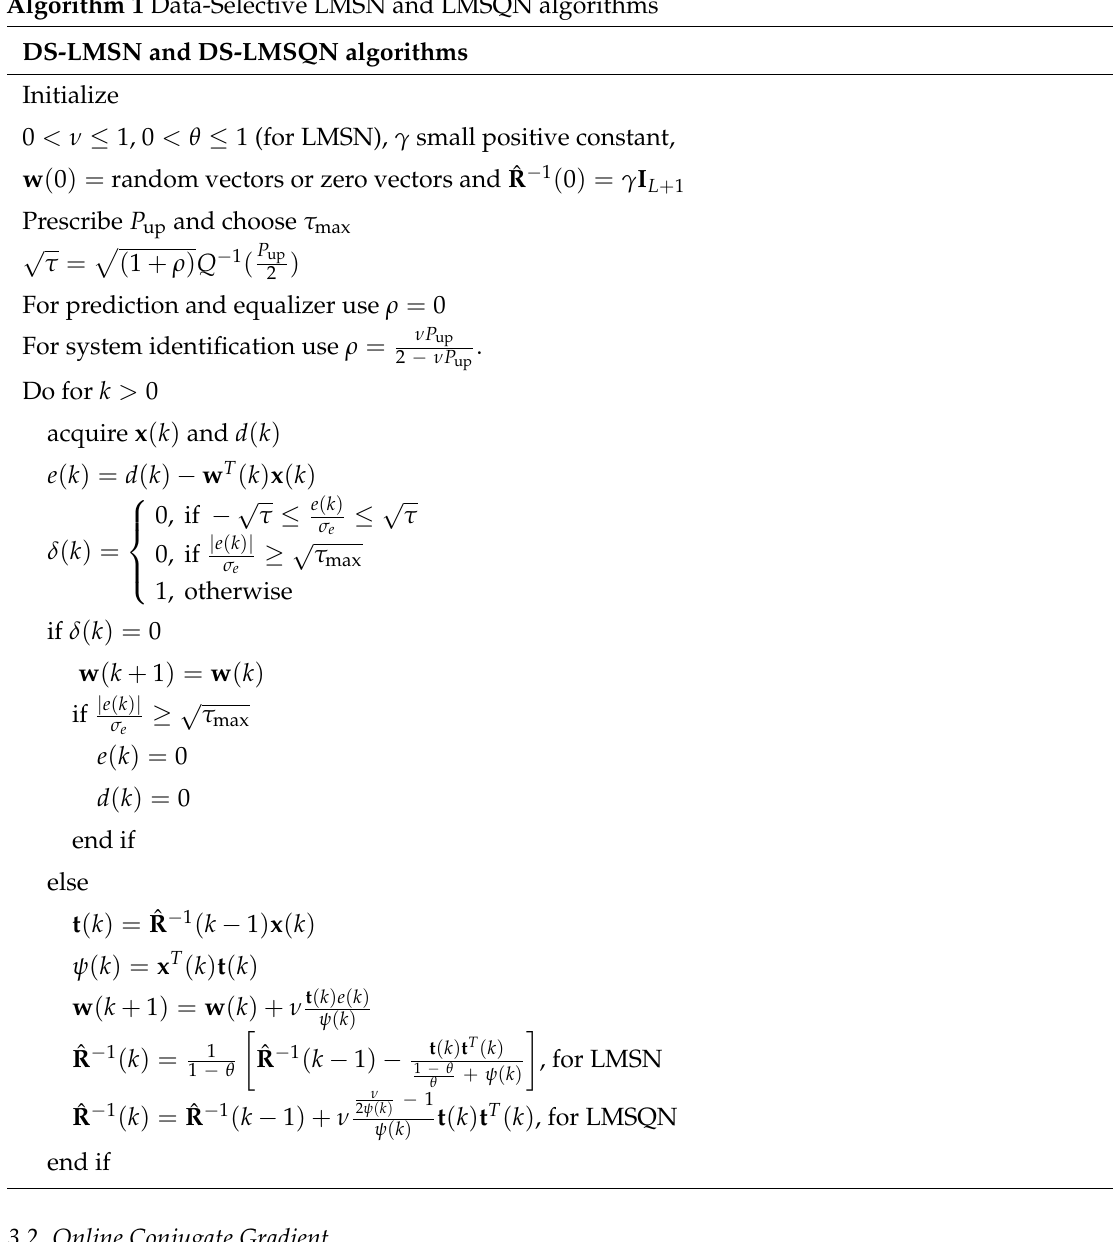
Algorithm 1 Data-Selective LMSN and LMSQN algorithms DS-LMSN and DS-LMSQN